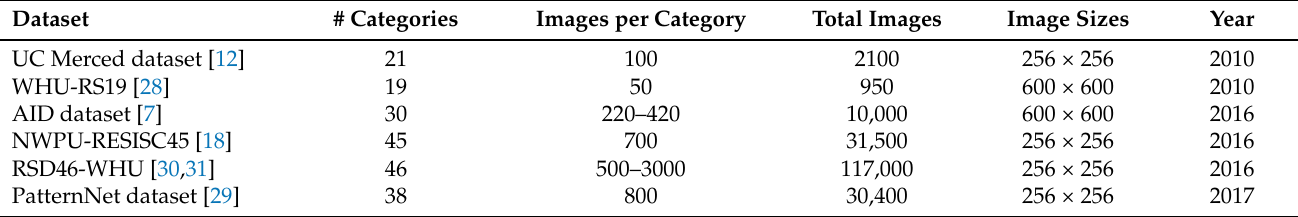
Table A1. Comparison of the six common aerial